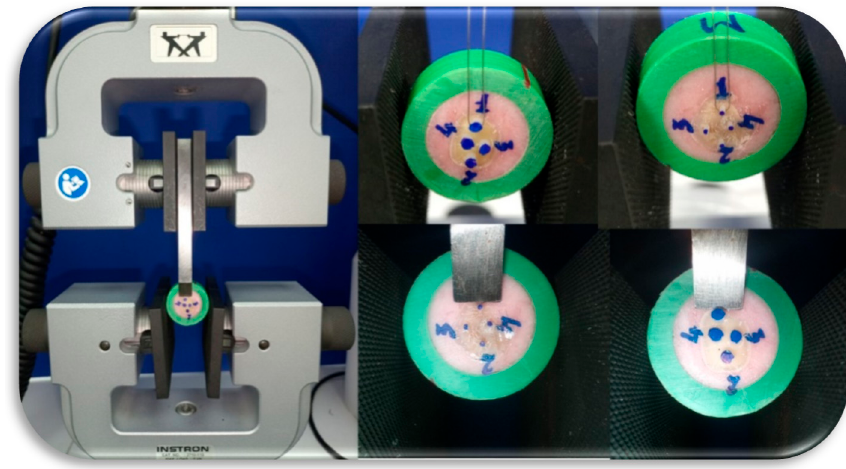
Figure 2. Macro- and microshear composite samples loading using chisel and wireloop.